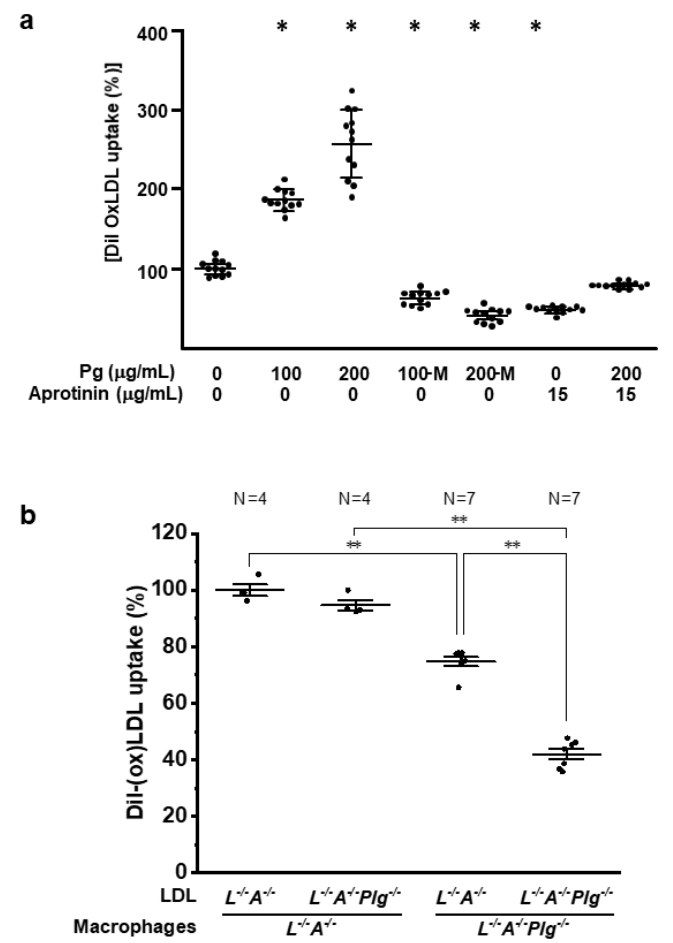
Figure 5. LDL/oxLDL uptake. ( a ) Purified and Dil-labeled oxLDL was incubated with bone marrow- derived macrophages from 12 wk L − / − /A − / − mice ( n = 12), in the absence or presence of increasing concentrations of Pg and in the absence or presence of the plasmin inhibitor, aprotinin. M—active site mutant Pg protein (PgS743A). * p < 0.05 versus (-) mPg and (-) aprotinin. ( b ) LDL was isolated from L − / − /A − / − and L − / − /A − / − /Plg − / − mice, Dil-labeled, and then incubated with bone marrow-derived macrophages from L − / − /A − / − (circles) or L − / − /A − / − /Plg − / − (squares) mice at 12 wk of age. Macrophages isolated from 12 wk mice and LDL obtained from 12 wk mice ( n = 4 for circles and n = 7 for squares) * p < 0.05. “*” is “**” between the pairs of comparisons.